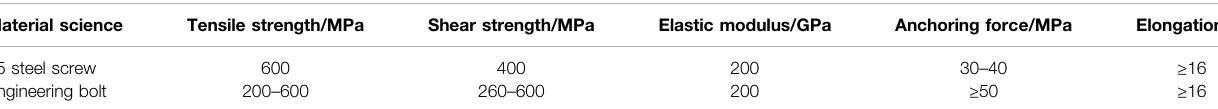
TABLE 1 | Mechanical parameters of 45 steel bolt and an engineering bolt.